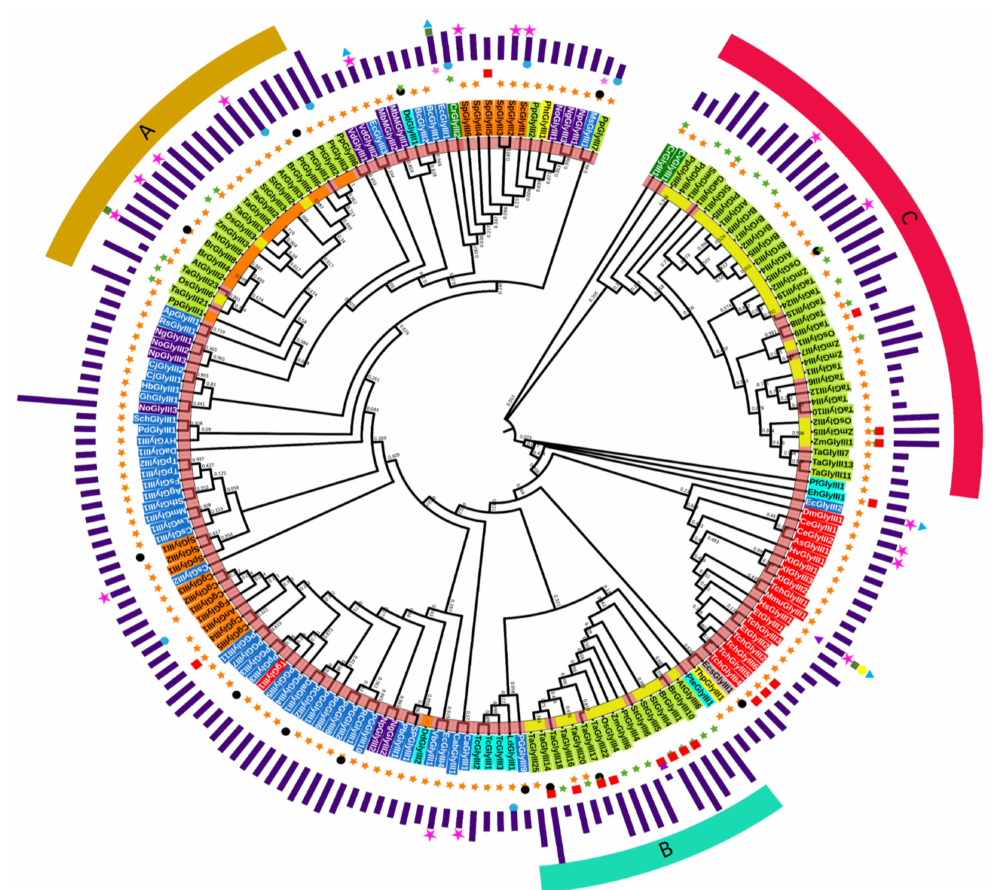
Figure 3. Phylogenetic analysis reveals three types of GLYIII proteins exist in plants. In all, 183 sequences from 69 species were used. The tree indicates the presence of three types of plant GLYIII proteins represented as cluster-A (mustard strip), B (pale-green strip), and C (red strip). Innermost strip indicates the length of linker region separating the two domains. Yellow-green color represents longer linker length (37–39 aa), orange indicates small linker length (9–20 aa), and light coral indicates no linker region. Purple bars on the outer side of the tree indicate protein length. Symbols next to protein names indicate different organellar localization patterns. Orange star indicates cytoplasmic localization, green star- chloroplast, purple star—periplasm, black circle-membrane (inner and outer membrane for prokaryotes, and plasma membrane for eukaryotes), blue circle—extracellular, red square—mitochondria, and purple triangle—nuclear localization. GLYIII proteins belonging to the different phylogenetic domains of life are depicted using specific colors as, archaea (purple), bacteria (blue), protists (cyan), fungi (orange), diatoms (yellow), brown algae (light brown), green algae (dark green), plants (light green), and animals (red). The different colored symbols above the bars (representing protein size) indicate different biochemical activities, i.e., GLYIII (pink star), chaperone (green square), protease (yellow circle), and deglycase (blue triangle). The maximum likelihood tree has been constructed with 1000 bootstrap replicates (indicated over branches) using MEGA-7.0 and visualized using